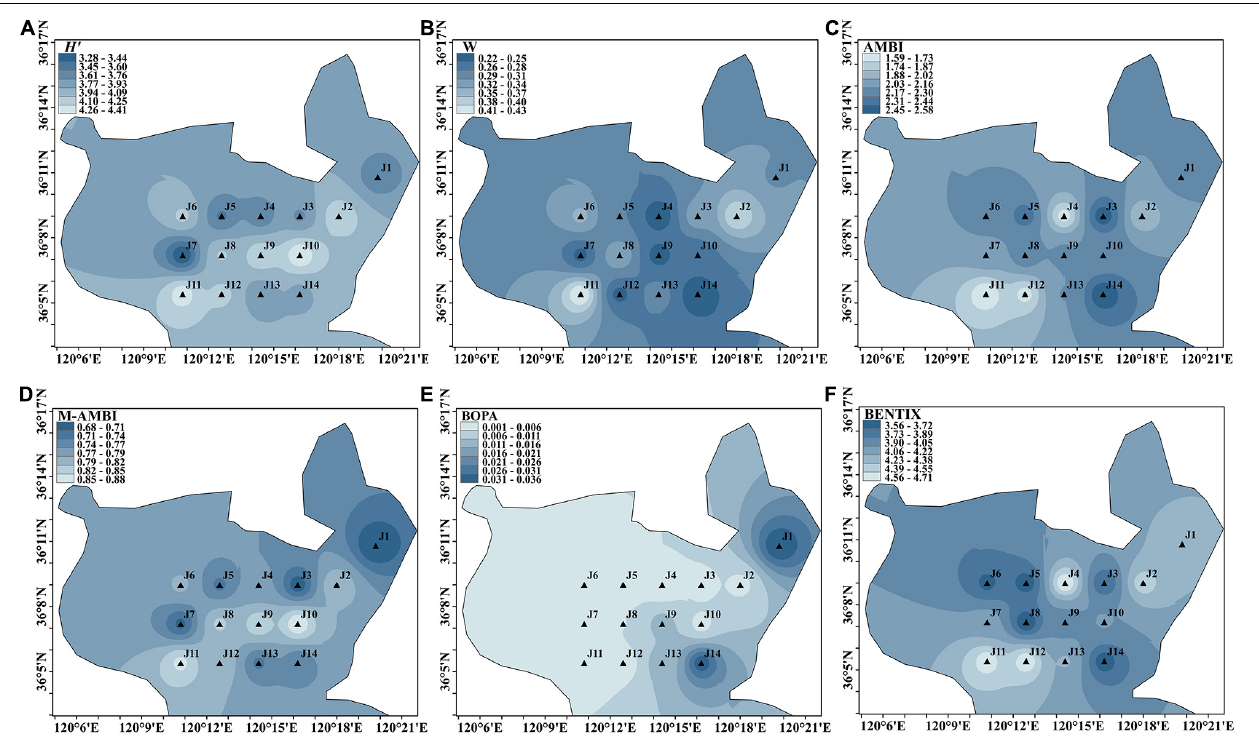
FIGURE 2 | Spatial distribution of environmental assessment in winter cruise in Jiaozhou Bay, H (cid:48) (A) , W (B) , AMBI (C) , M-AMBI (D) , BOPA (E) , and BENTIX (F) .